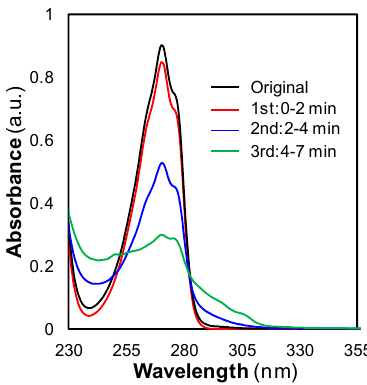
Figure 10. Spectra for the original phenol solution and the three samples collected during a SCW regeneration assay.